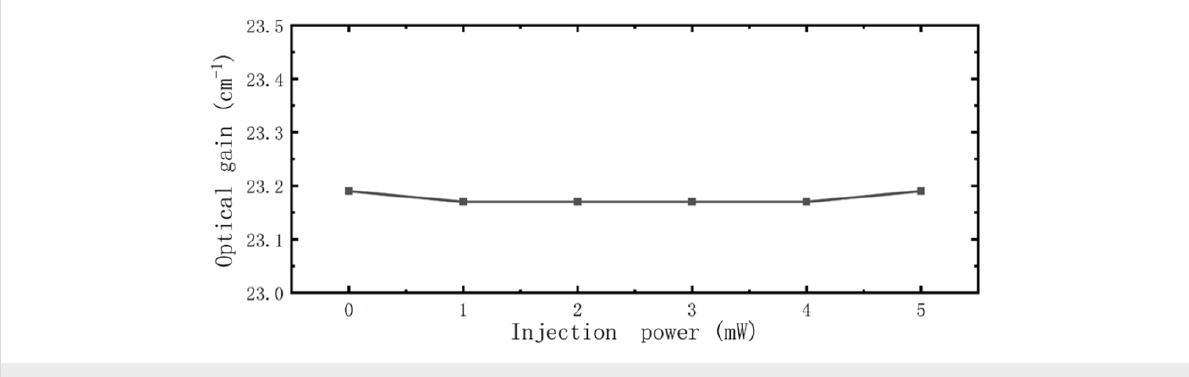
Figure 5: Optical gain as a function of optical injection power.